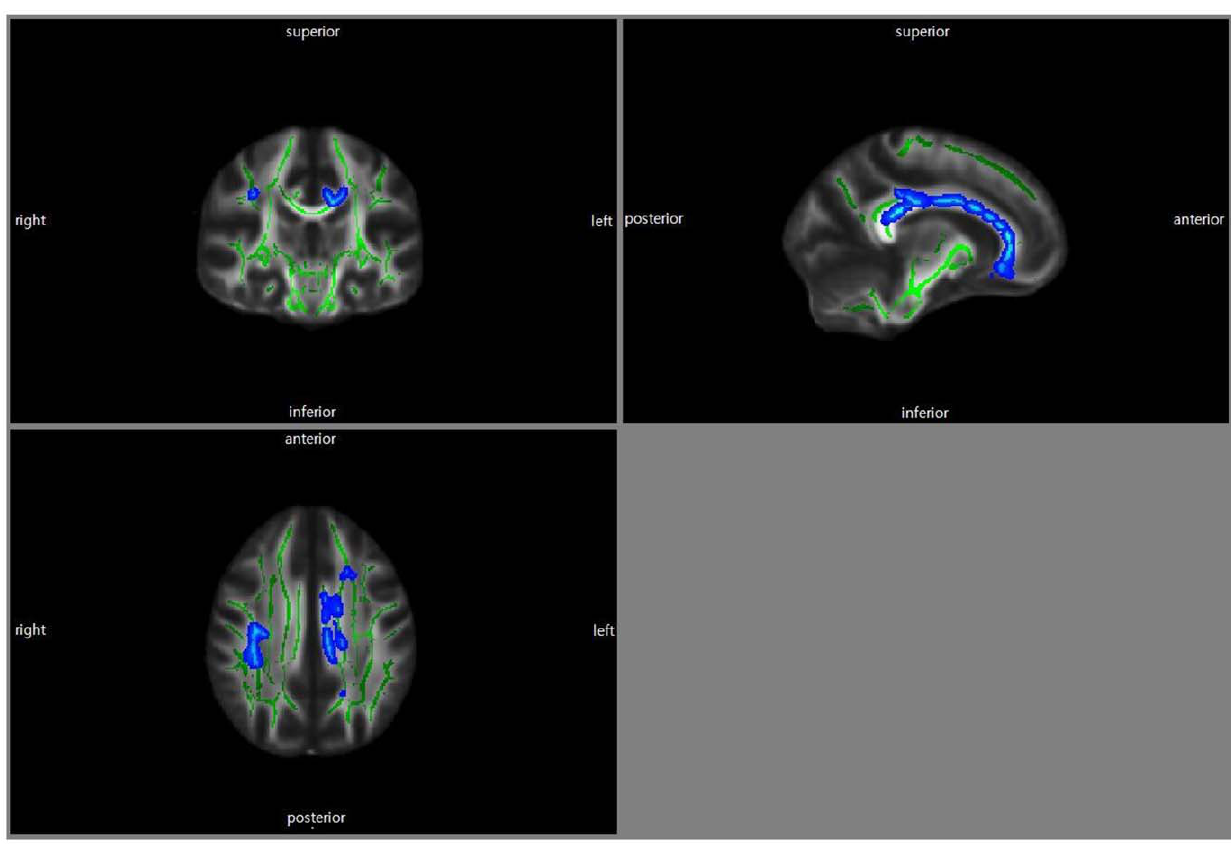
Figure 2. Correlation between IA scores and FA values. Statistical maps showing the regions of lower FA values correlated with IA scores. The results were color-coded by p corrected , 0.05. FA, Fractional Anisotropy; IA, Apathy Inventory.